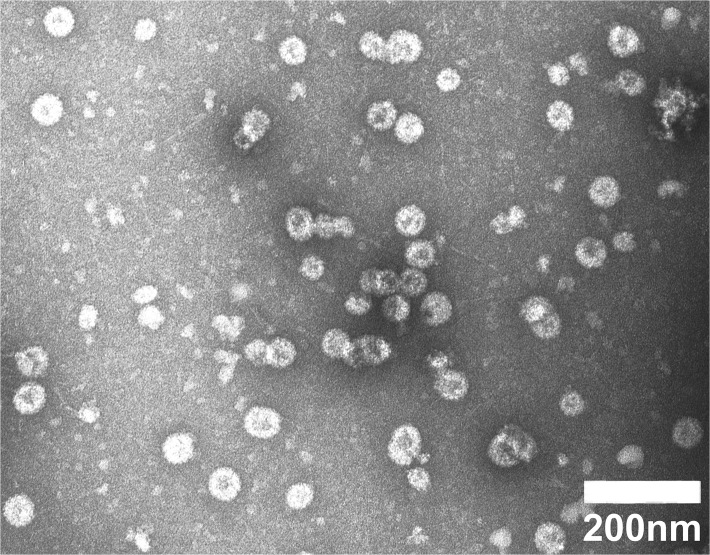
Transmission electron microscopy of chimeric HPV18L1–45RG1 VLP.VLP were gradient-purified, negatively stained and visualized at 30,000-fold magnification using a JEOL 1010 electron microscope. The size of the bar indicates 200nm.